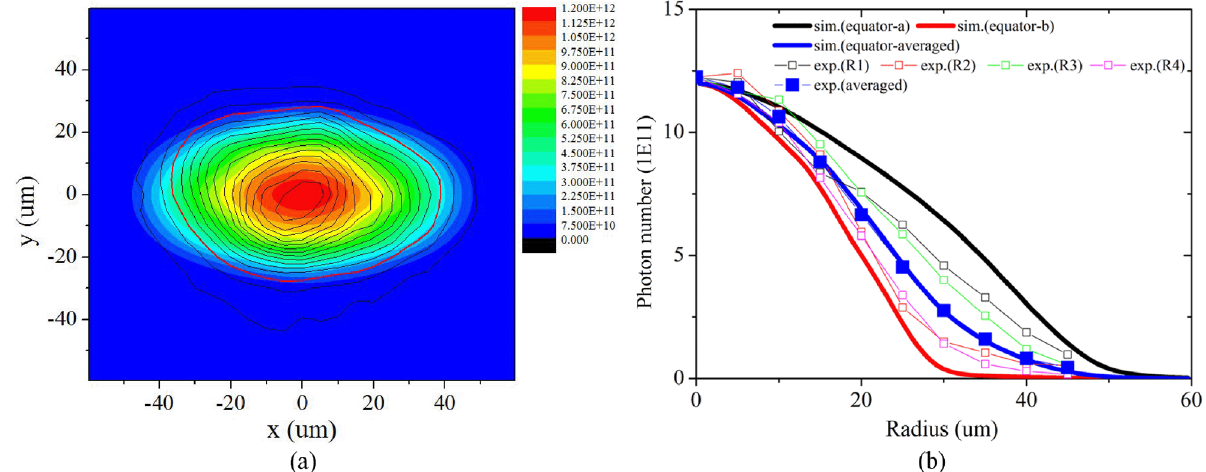
Figure 8. (Color online) ( a ) Self-emission distributions of the core area including DD fuel and self-emission of ablator with the P2 drive asymmetry=2.5% as per calculations. The contour lines are extracted from the experimental results in Fig. 4(e). ( b ) Comparison of radial distributions of the number of photons extracted according to experimental and simulation results, namely Figs. 4(e) and 8(a) respectively. Black solid curve shows distribution along the long axis equator-a of the simulation results, red solid curve is the distribution along the short axis equator-b, and blue solid curve is the average distribution along different angles. The squares are experimental data from Fig. 4(e). Hollow squares are the radial distributions of different radii along up, down, left, and right orientations (R1 to R4). Blue solid squares are the average results of eight radii, including another four radii 45 ◦ relative to R1–R4. The center of all the radii is the point of maximum emission